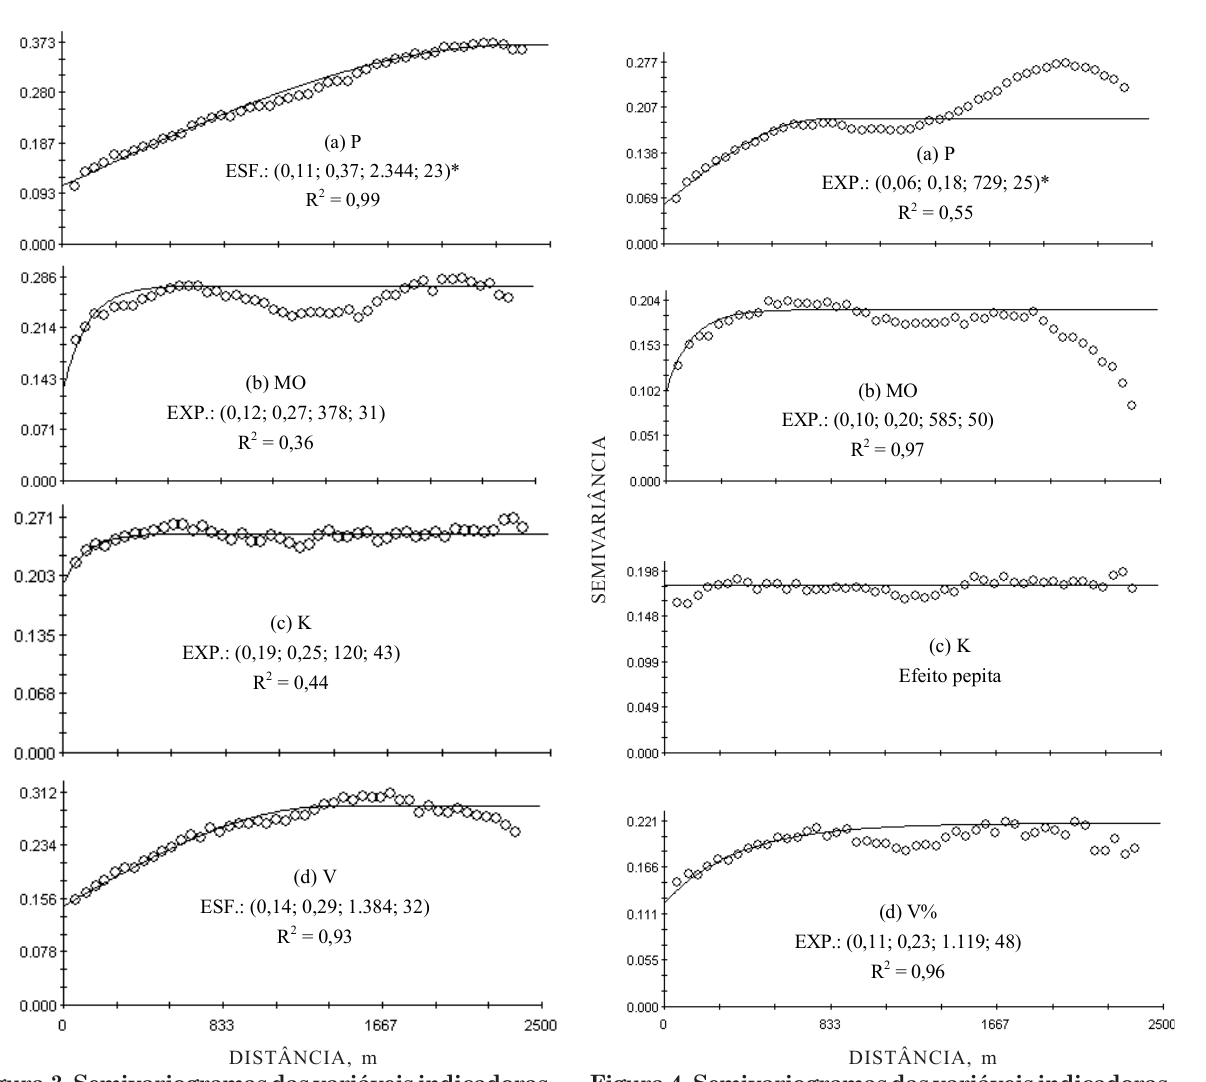
Figura 4. Semivariogramas das variáveis indicadoras, quando se utilizaram, como valores de corte, os valores do 3 o quartil: (a) fósforo; (b) matéria orgânica; (c) potássio e (d) saturação por bases. * MODELO: C ; Patamar (C + C); Alcance; C / 0 0 0 + C). EXP. = Exponencial. (C 0